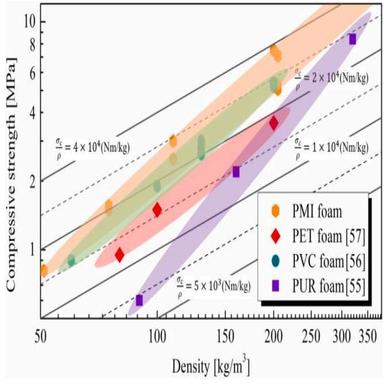
Comparison of the compressive strength of different polymeric foams with different densities. The black solid and dotted lines are the isoline of specific density of compressive strength ( σc ρ ), which indicate the specific strengths of these polymeric foams.